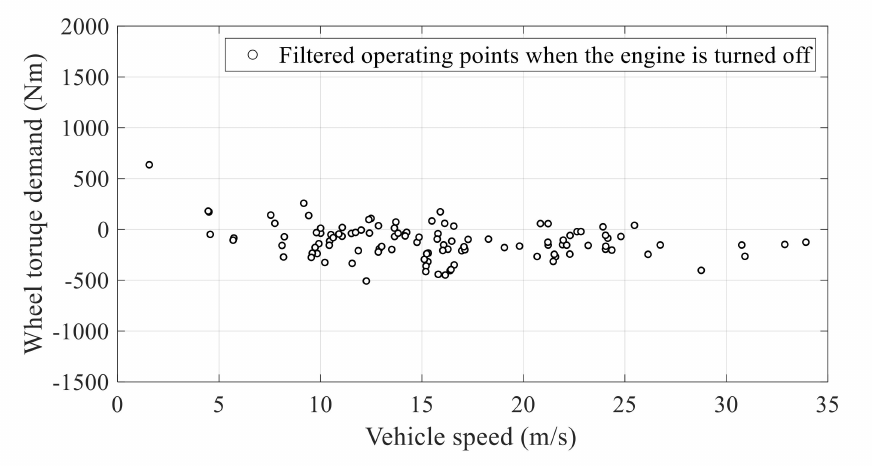
Figure 12. Operating Points When the Engine is Turned o ff .